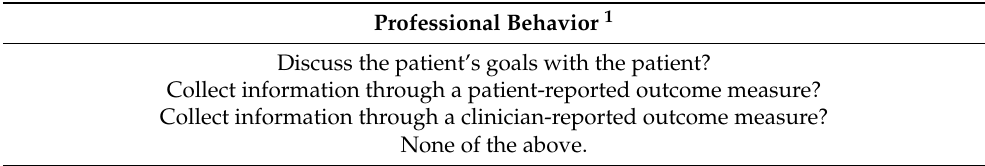
Table 1. Professional behaviors performed for PCC core